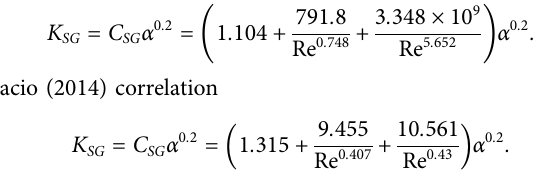
For each spacer grid, the blockage ratio is constant, so the spacer grid resistance is a function of the Reynolds number. The measured spacer grid resistance is in the form of the power function of Re (Lee et al., 2012).